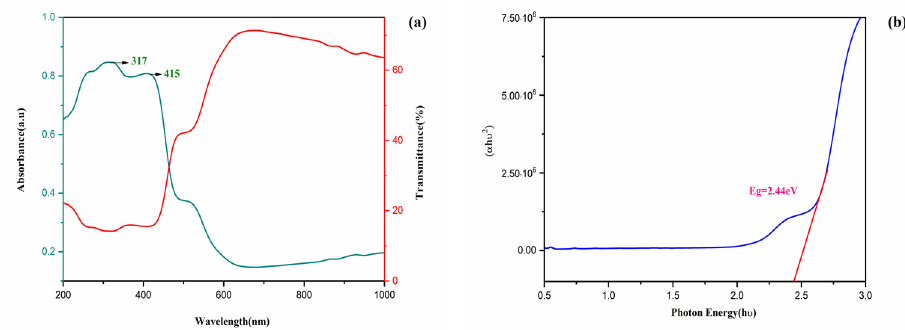
Figure 9. ( a ). UV–Vis–NIR transmittance and absorbance spectrum, ( b ) Tauc’s plot of